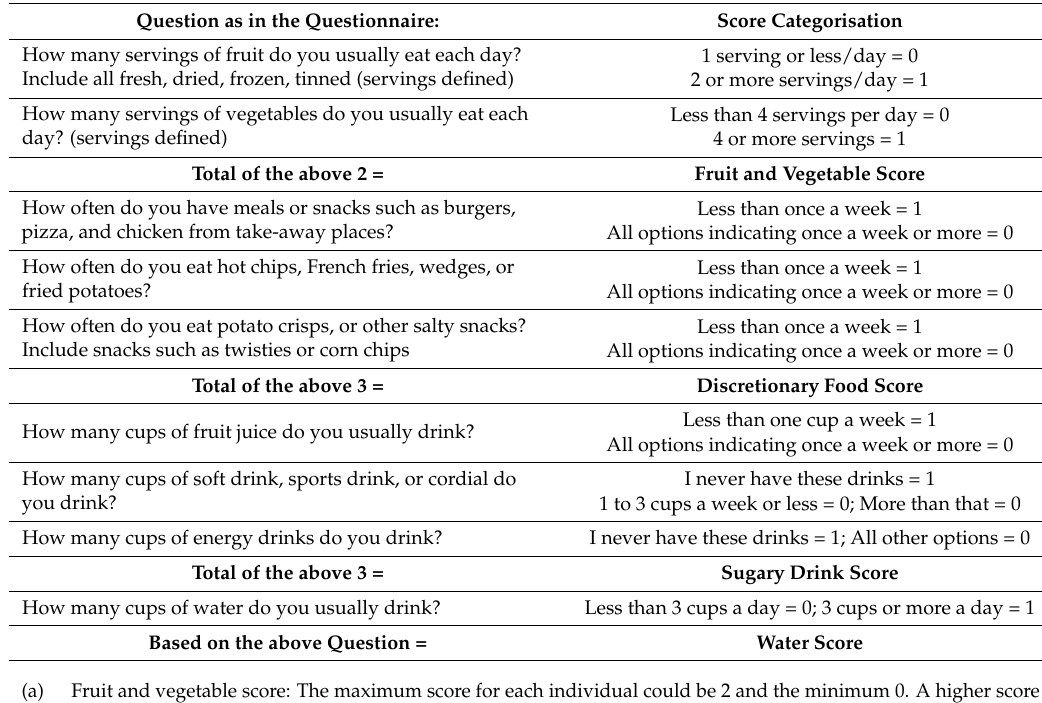
Table 1. Questionnaire questions and scores regarding diet intake of